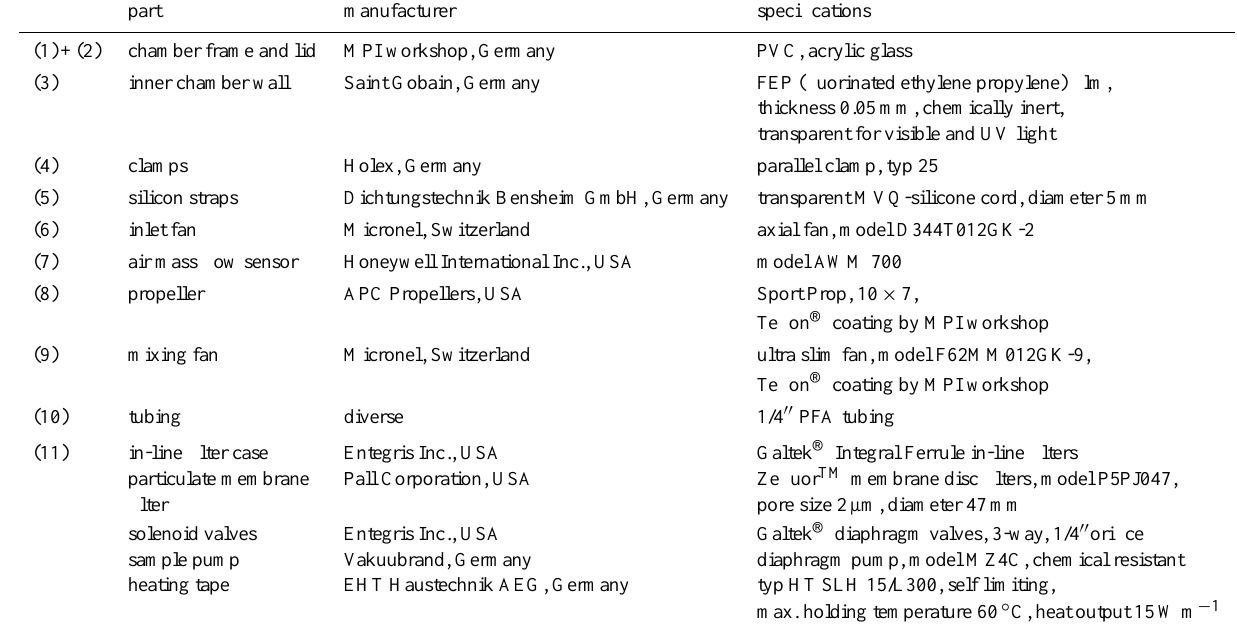
Table 4. Manufacturer details for parts of the dynamic chamber